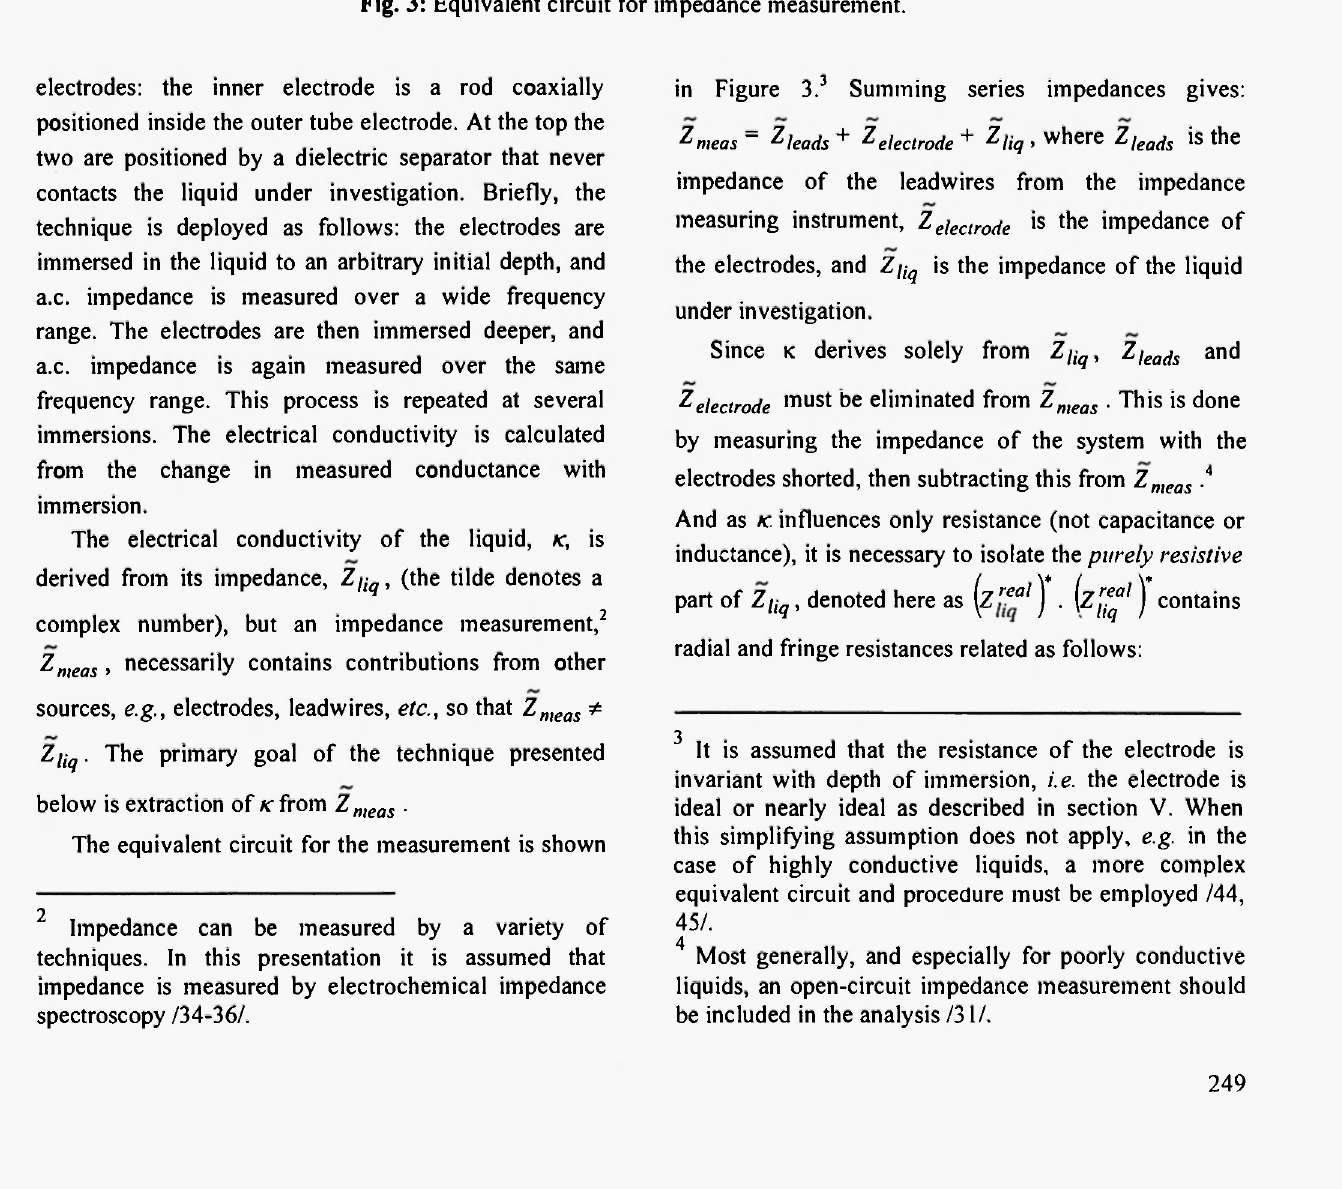
Fig. 3: Equivalent circuit for impedance